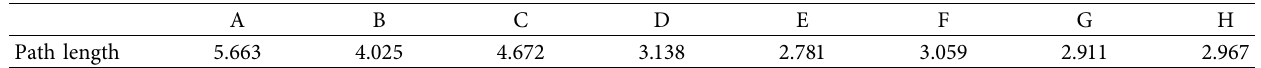
Table 10: Average path length of professional athletes’ social